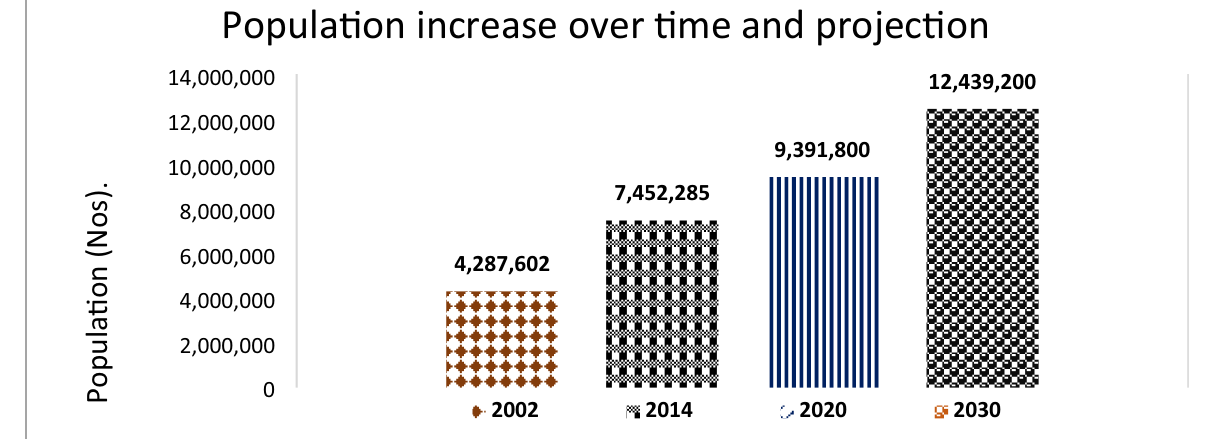
Fig. 5 Population dynamics over the study period (2000–2020) and projections for